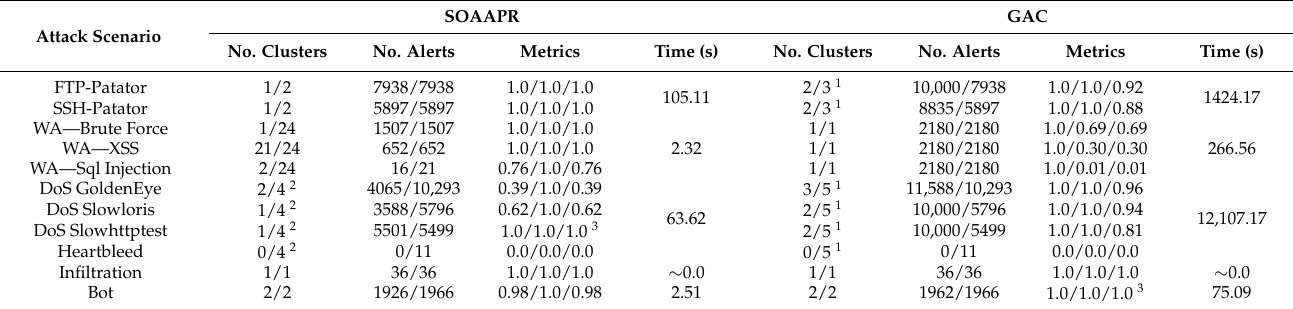
Table 4. Clustering performance results of SOAAPR and GAC on 11 attack scenarios of the CICIDS2017 datasets (No. Clusters—assigned cluster(s)/generated cluster(s); No. Alerts—assigned alerts/actual number of alerts per attack sce- nario; Metrics— COMP / SOUND / JAC ; Time denotes the total amount of processing time for each dataset containing the respective attack